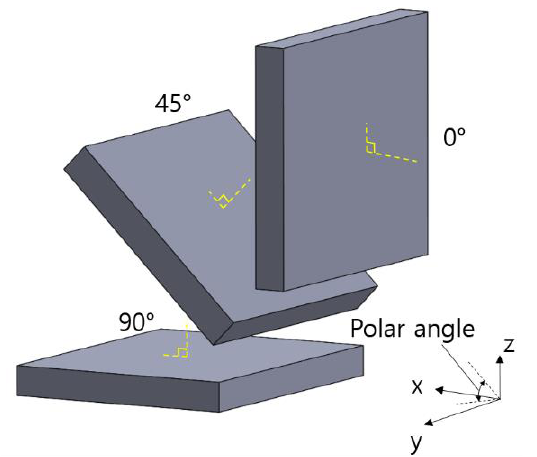
Figure 1. Schematic description of thermal conductivity test samples on the substrate plate.